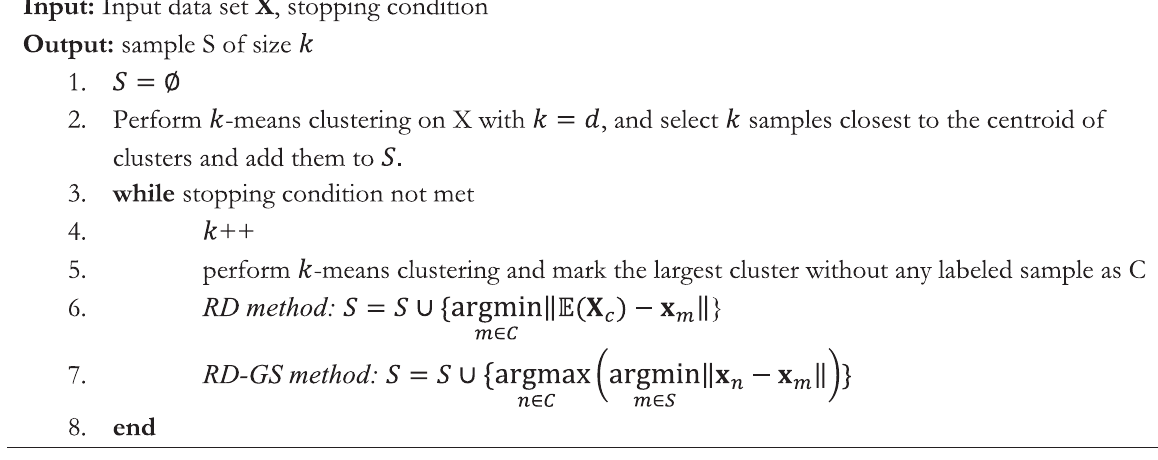
Algorithm 2 | – RD/RD-GS (Wu, 2018)